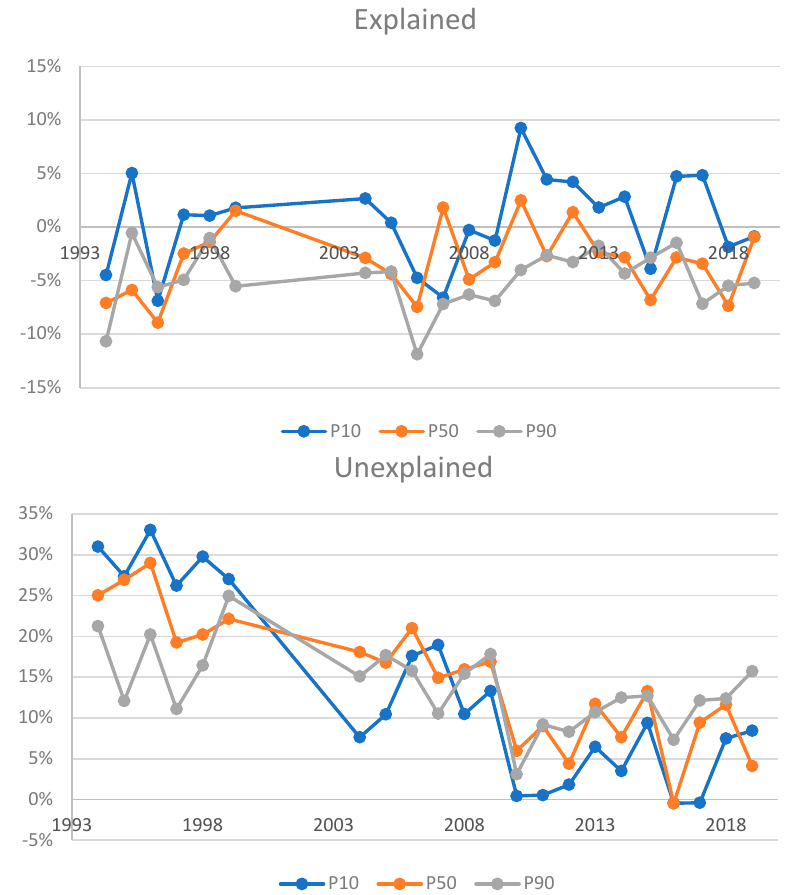
Figure A2. The explained and unexplained portions of the gender wage gap at selected quantiles. Source: Authors’ calculations using the ESRI Survey of Income Distribution, Poverty and Usage of State Services, the Living in Ireland Survey, and the European Union—Survey of Income and Living Conditions. Notes: Limited to respondents aged 25–55 and excluding the self-employed. Wages are CPI adjusted and weighted.